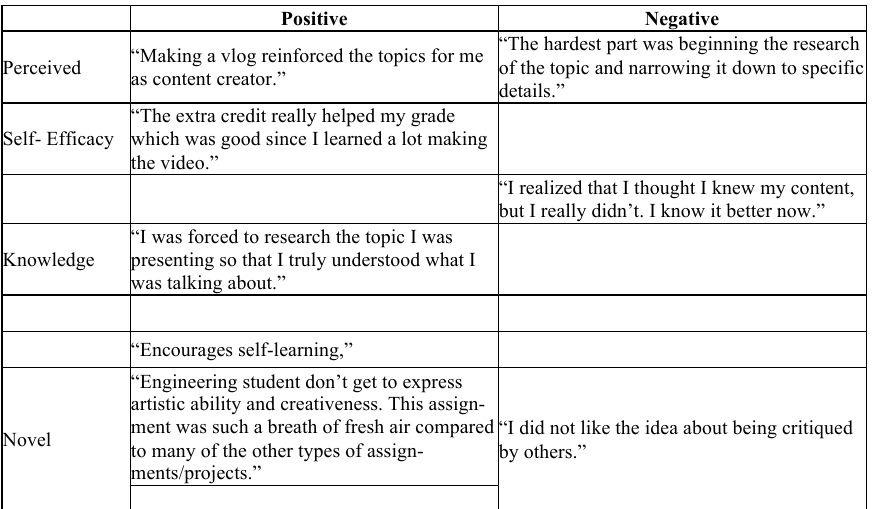
Table 4. Classified Vloggers